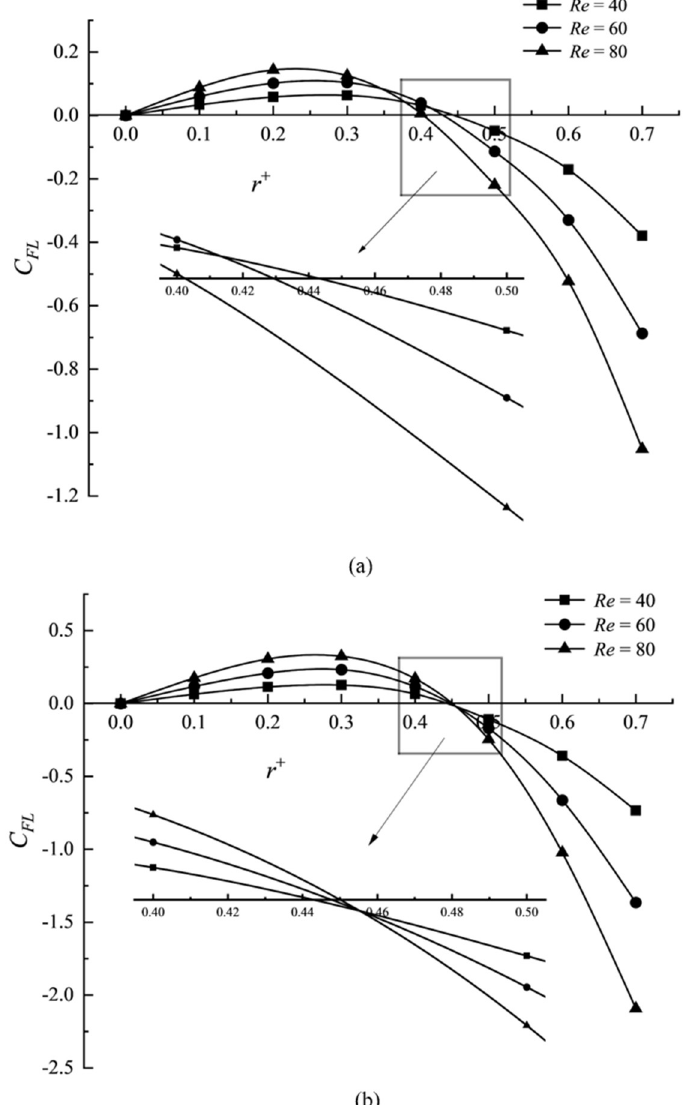
Fig 8. Lift distribution of elliptical particles and its corresponding circular particles under different Re . (a) elliptical particles and (b) circular particles.